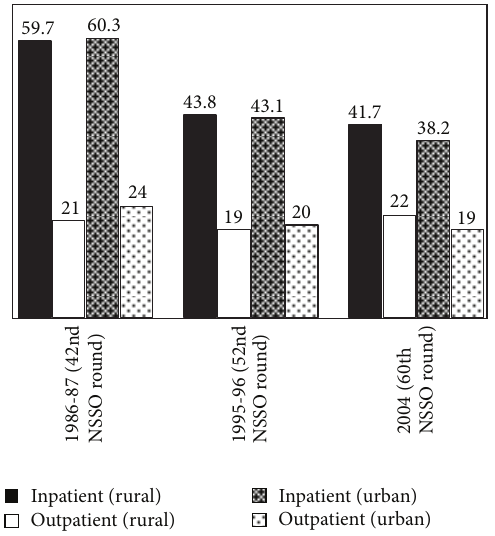
Figure 3: Inpatient and outpatient share of public hospitals in rural and urban areas. Source: